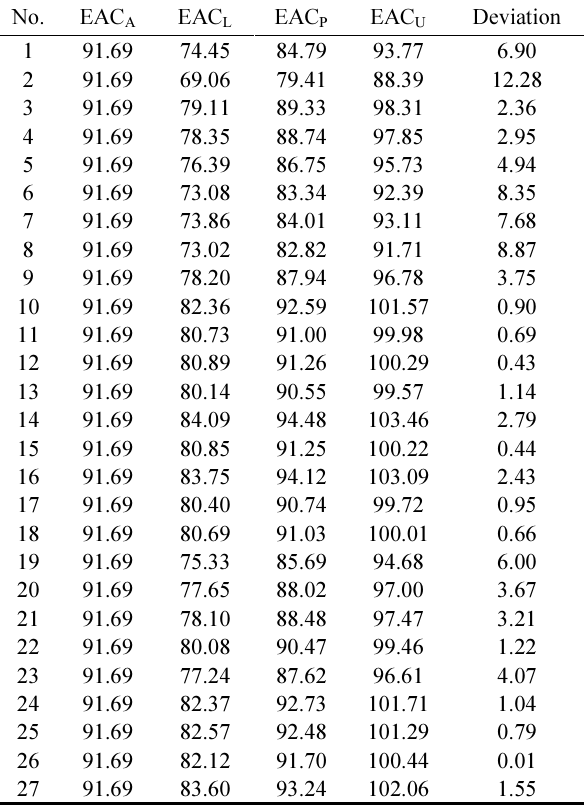
Table 5. Interval Estimation of EAC for project 12